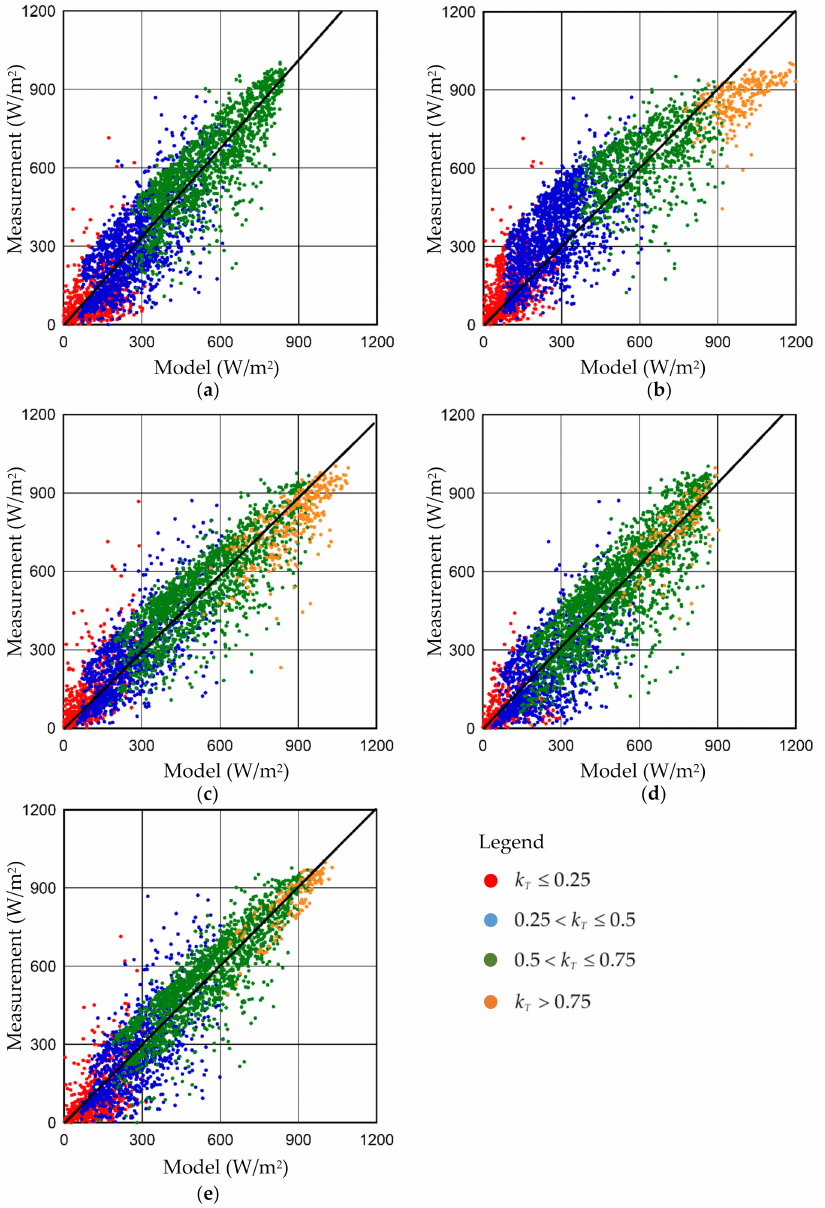
Figure 6. Comparison of modeling results with measurement data by the level of the clearness index; divided into four classes with the interval of